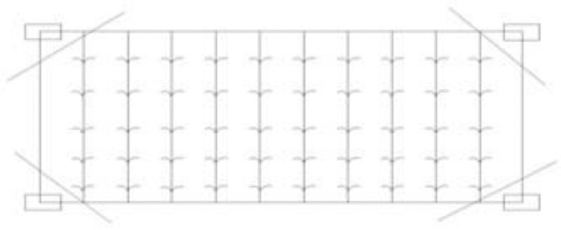
Figure 4: Floating raft method.